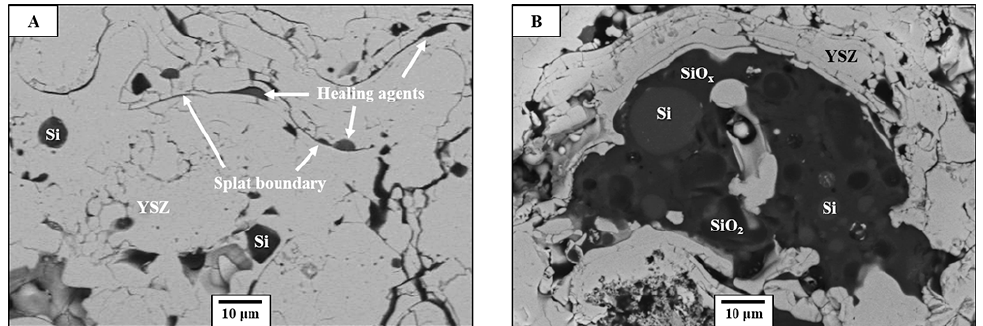
Figure 7. Magnified microstructure around the healing agent in as ‐ coated samples: ( A ) sample B, and ( B ) sample